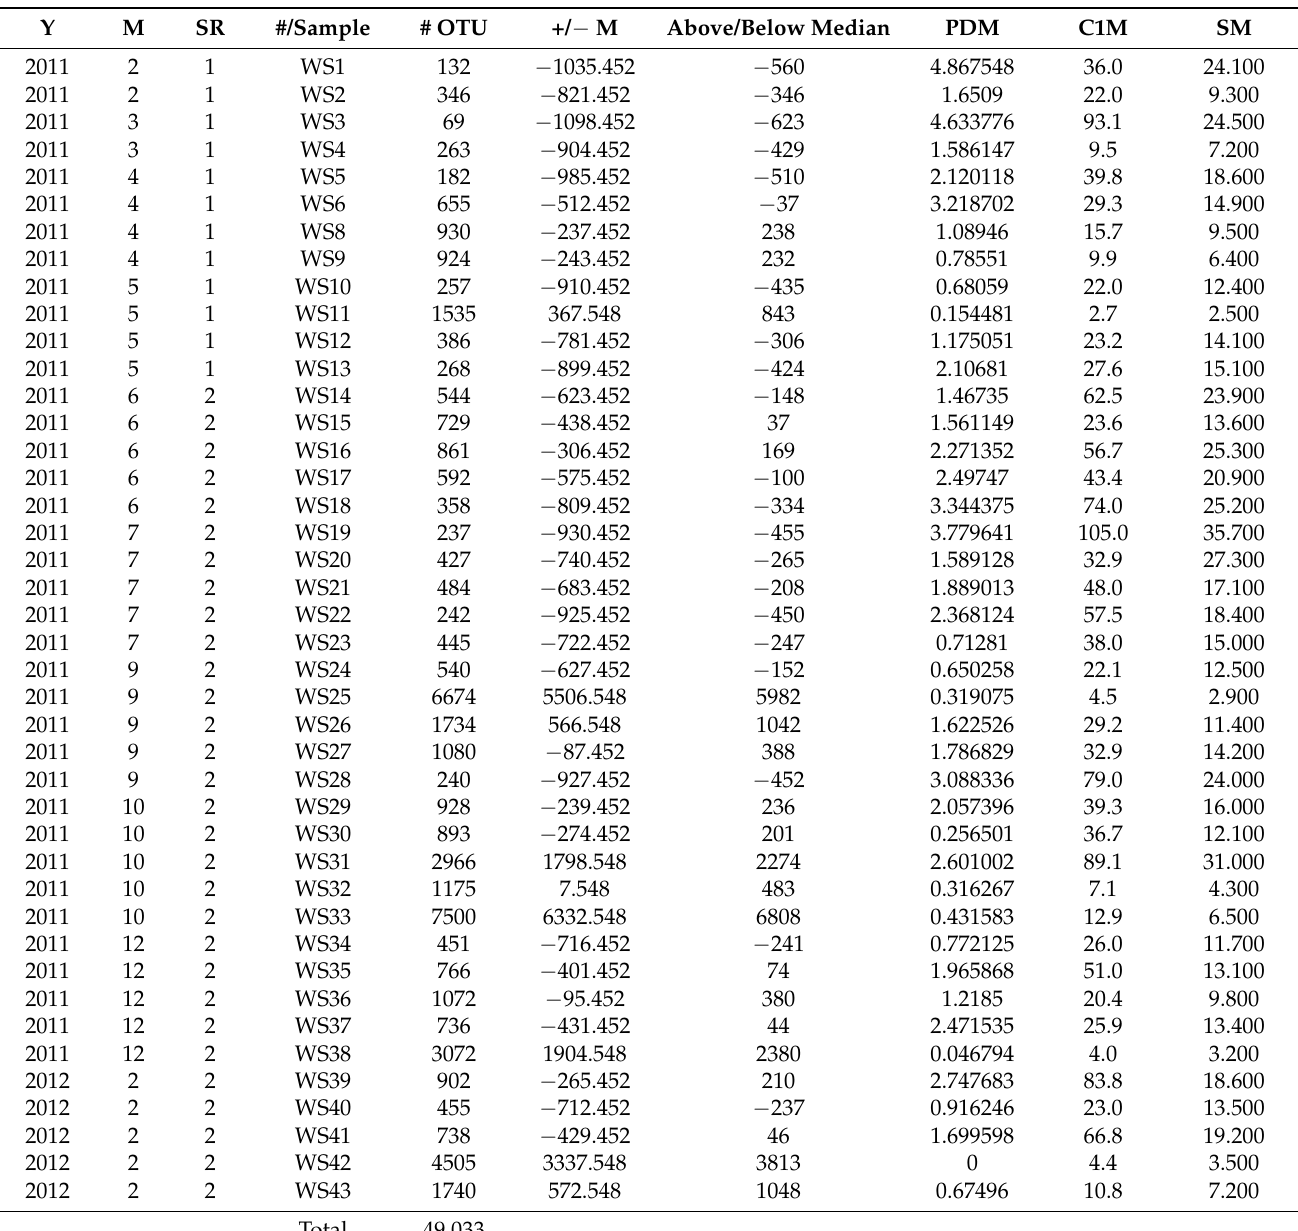
Table 4. OTU table count of reads from WaMS sample between 2011–2012. Y: year, M: month, SR: sequence run (run 1 was carried out first and reported in Stern et al., 2015), #: number, PDM: Phylogenetic distance whole tree mean, C1M: Chao I mean, SM: Shannon mean, +/ − M: above/below the